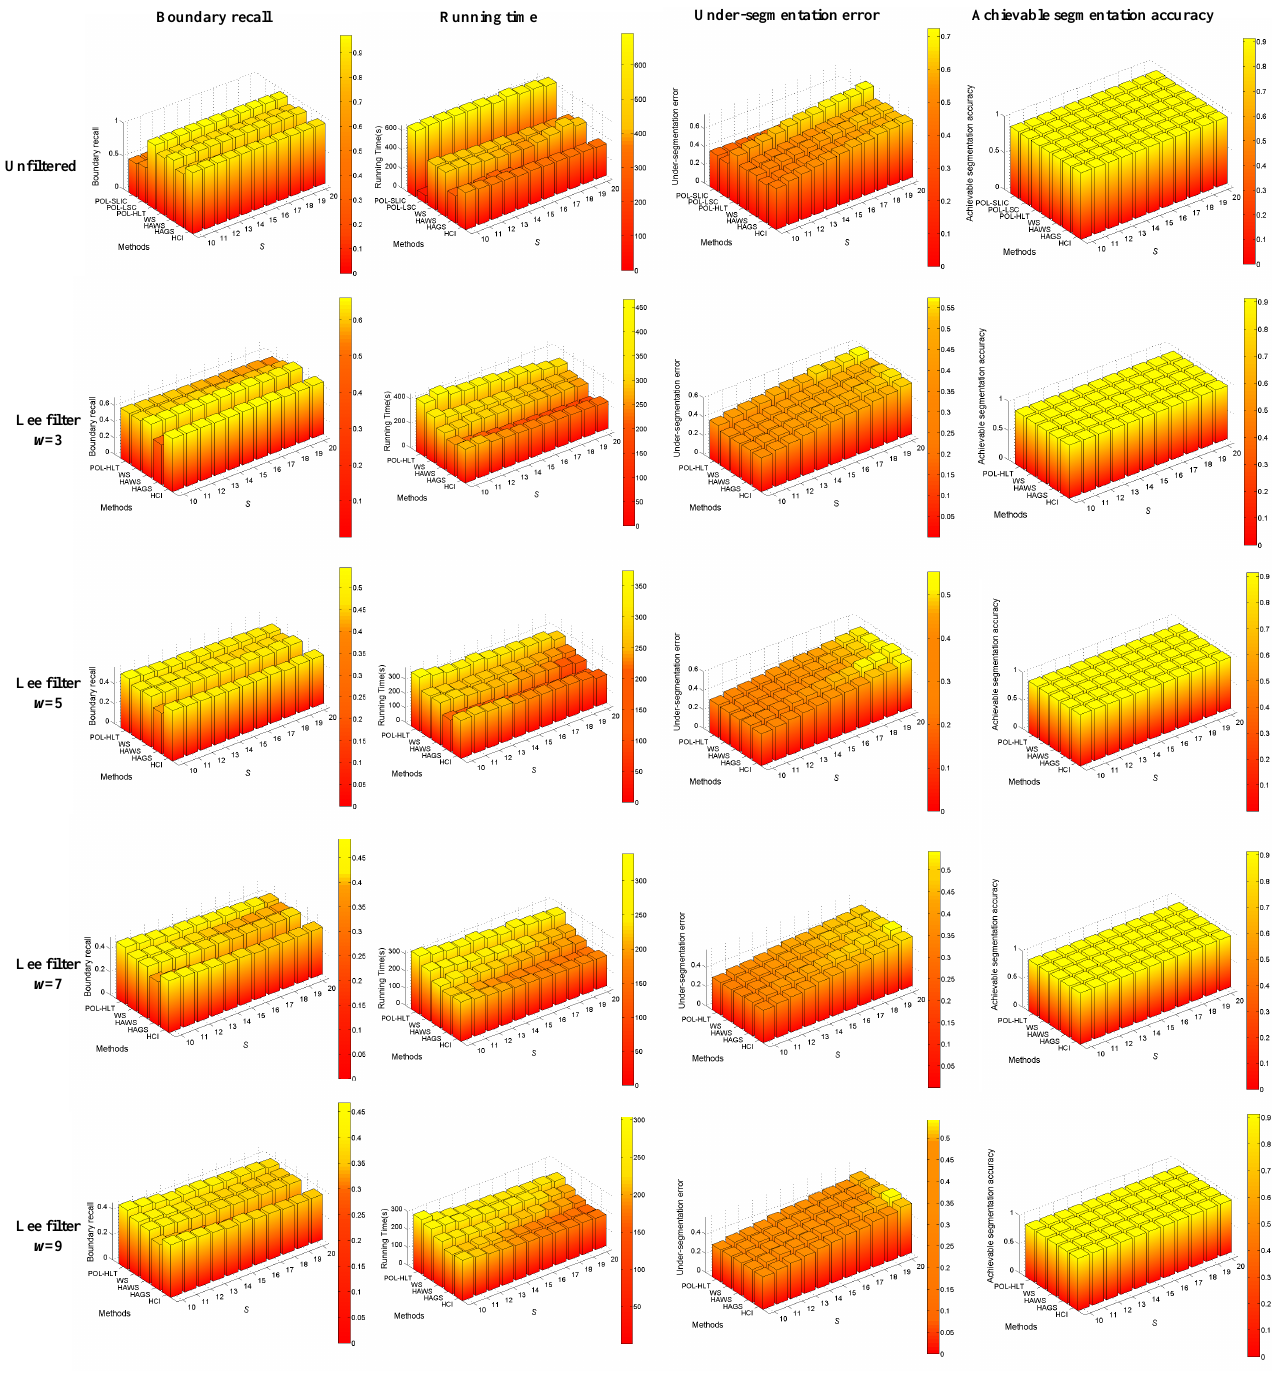
Figure 18. Quantitative evaluation results of the RADARSAT-2 data set. The first through fourth columns represent the BR, RT(s), USE and ASA. The first through fifth rows represent the results based on the unfiltered image and four sizes of Lee